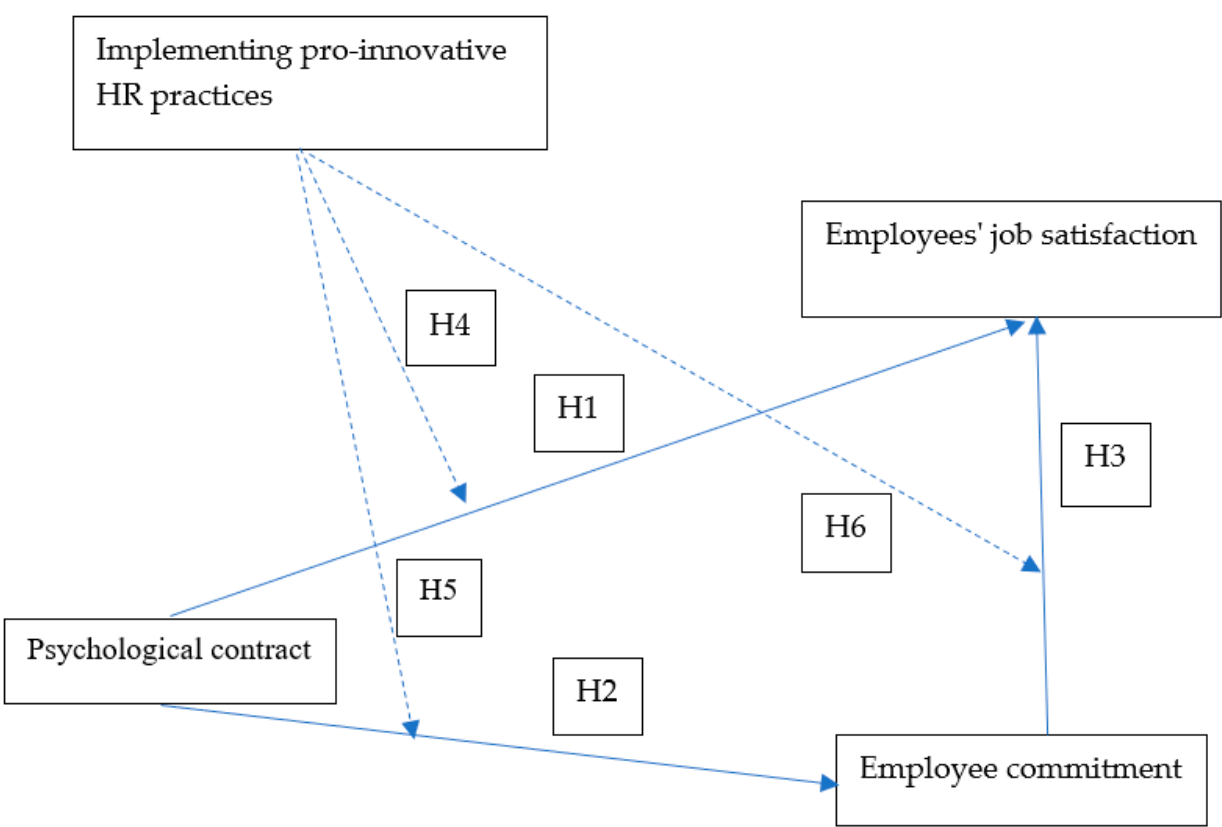
Figure 1. Hypothetical research model. Source: created by the authors.